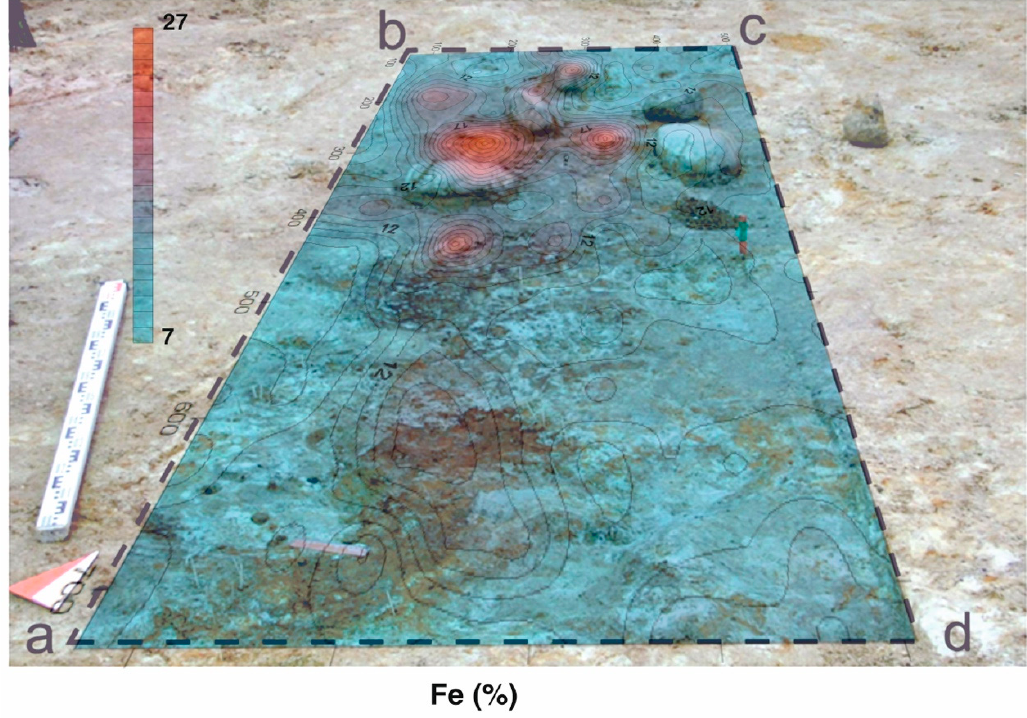
Figure 6. Distribution of Fe (%) on the surface of the burial layer at the Okhta 1 site [38], designed by M.Kulkova.